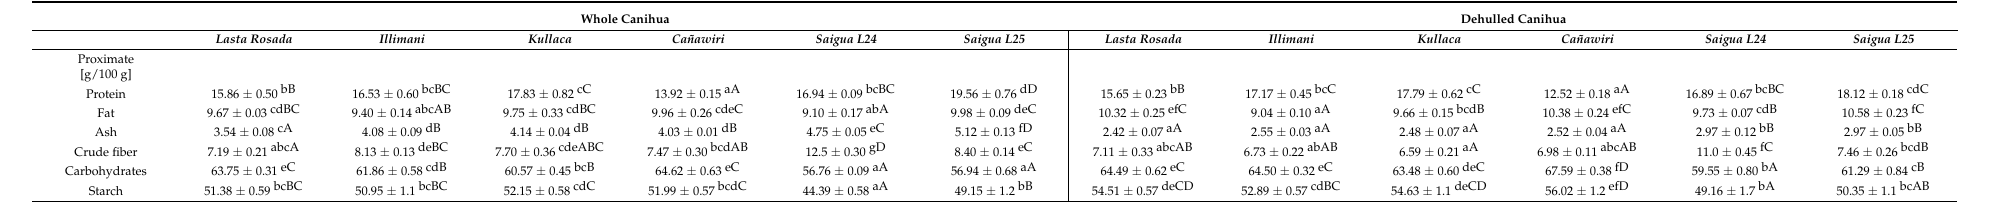
Table 2. Proximate composition of canihua ( Chenopodium pallidicaule ) cultivars. All values [g/100 g] are presented in dry weight (dw), as mean ± standard deviation ( n = 3). For each compound, different superscript lowercase letters in rows indicate significant differences between canihua samples ( p < 0.05), and different uppercase letters indicate a significant difference between whole or dehulled grains.